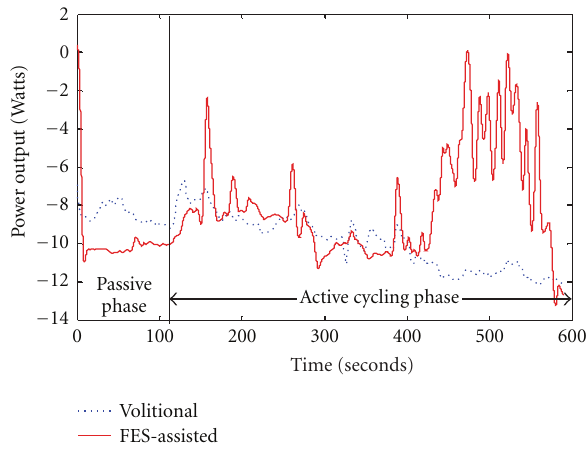
Figure 6: Power output during constant load cycling tests with (red line) and without (blue line) FES assistance. This data are from a child without cycling experience (participant 3) and the auxiliary hub motor was required for testing. The vertical black line at 120 seconds denotes the transition from a passive cycling phase (in which the motor moved the child’s legs while he rested) to an active phase (in which the motor continued to control cadence, and the participant assisted with the cycling e ff ort). In the FES assistance condition, the stimulation was applied only during the active cycling phase. Data were smoothed for analysis using a second-order lowpass Butterworth filter with a cuto ff frequency of